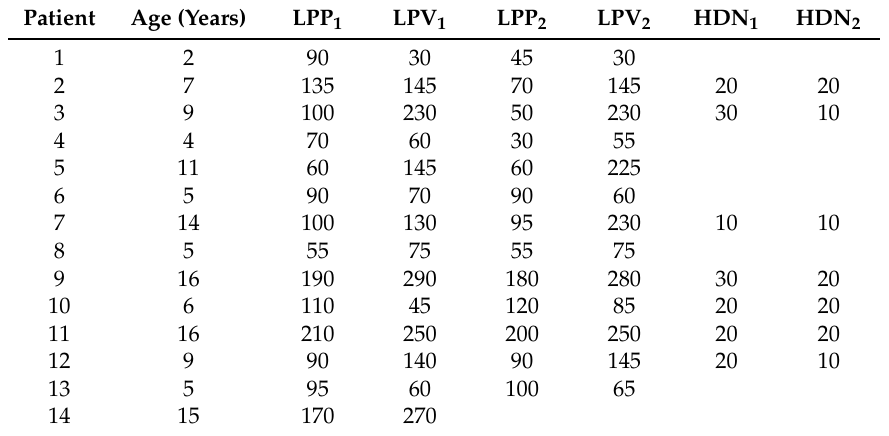
Table 1. Data from urodynamic and ultrasonographic investigations before and after the treatment. Patient Age (Years) LPP 1 LPV 1 LPP 2 LPV 2 HDN 1 HDN